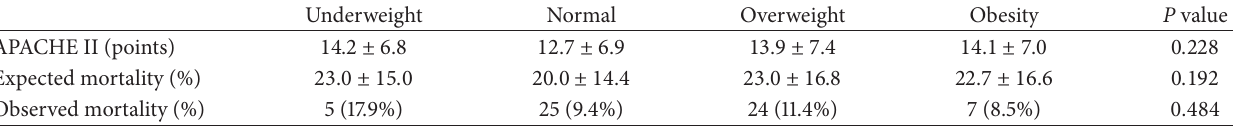
Table 3: Risk profile measured by the APACHE II score, its expected mortality, and outcome.